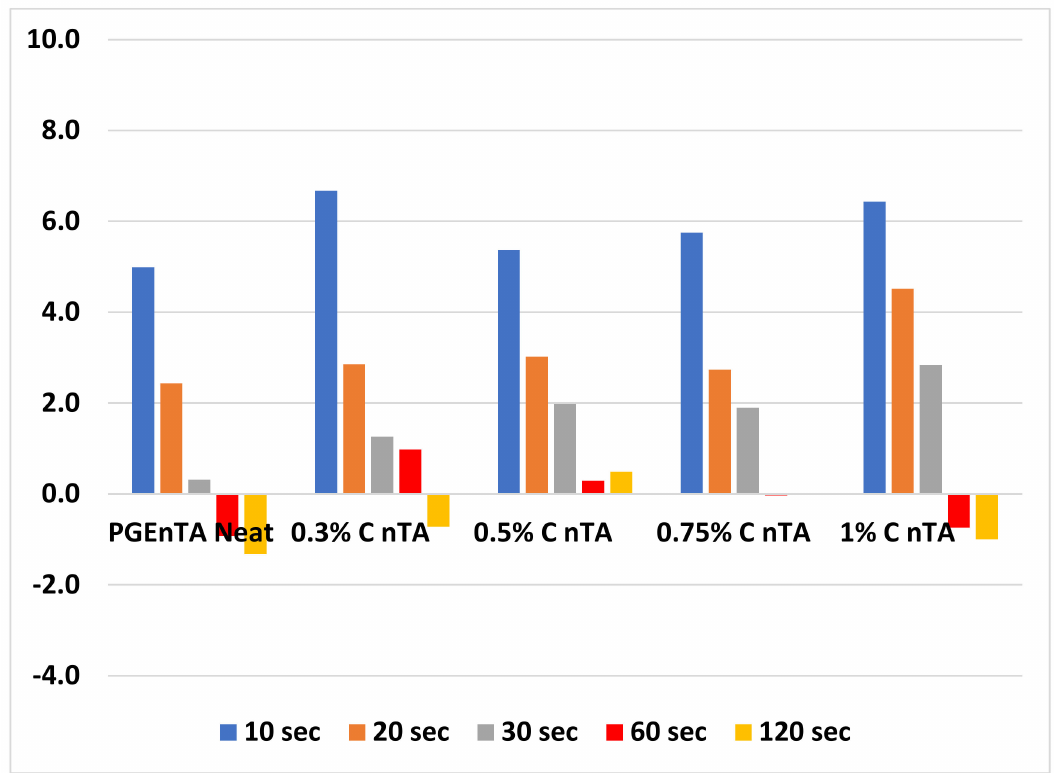
Figure 12. The DC differentials between the near side and far side of PGEnTA with WS 2 -C at various